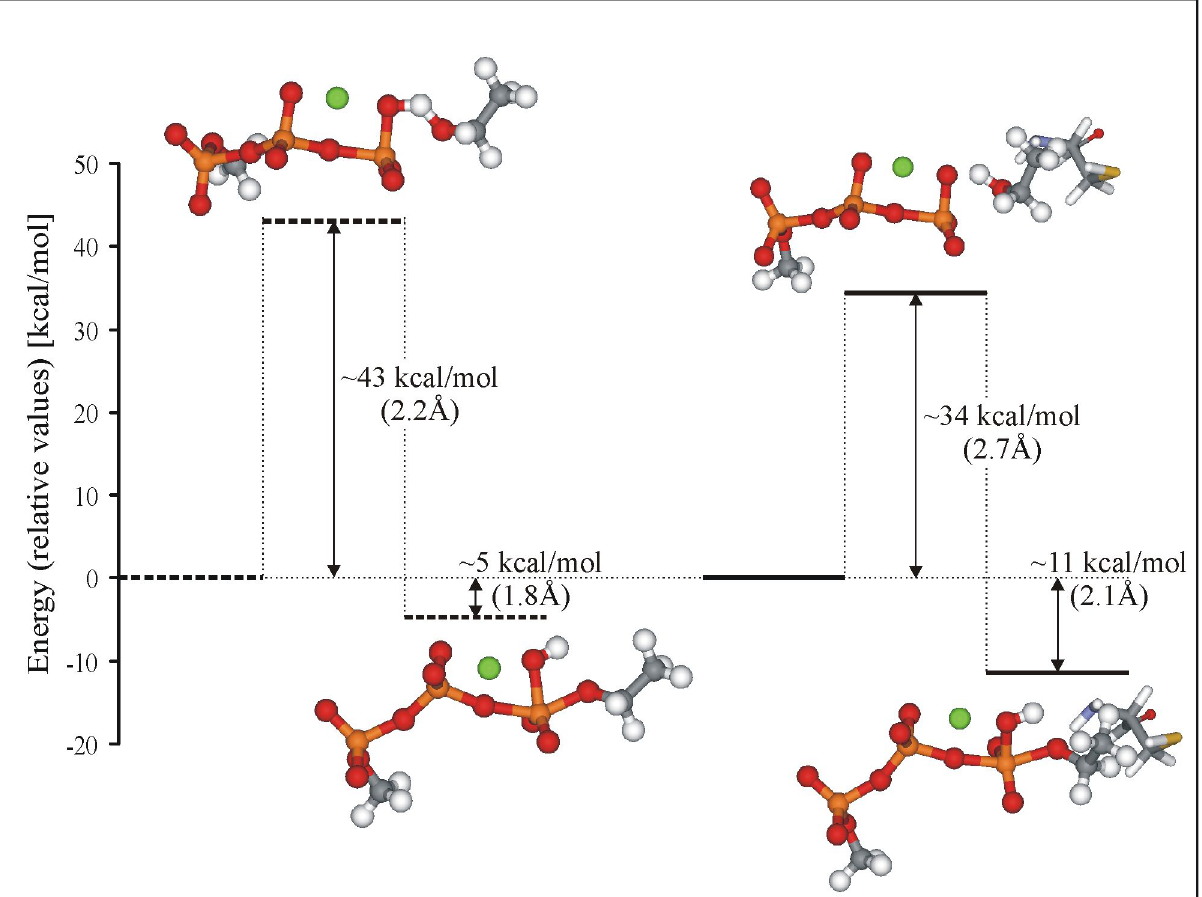
Figure 6. The energy (heat of formation) changes along the reaction coordinate (distance of  phosphorus atom from the nucleophilic oxygen atom of hydroxyl group) ; broken and full horizontal lines correspond to the substrates only and substrates together with cysteine containing models, respectively. Geometries of investigated models for the marked levels of energy are also presented. In parentheses are given the related reaction coordinate values. For both models the initial reaction coordinate value is 4 Å